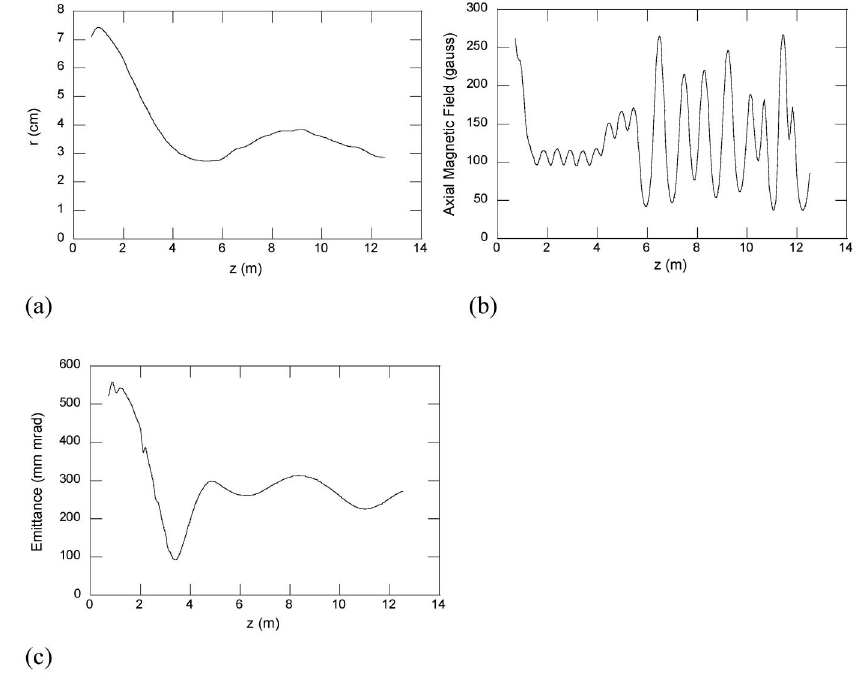
FIG. 25. Commissioning tune: (a) rms beam radius evolution, (b) applied external magnetic field, and (c) rms beam emittance